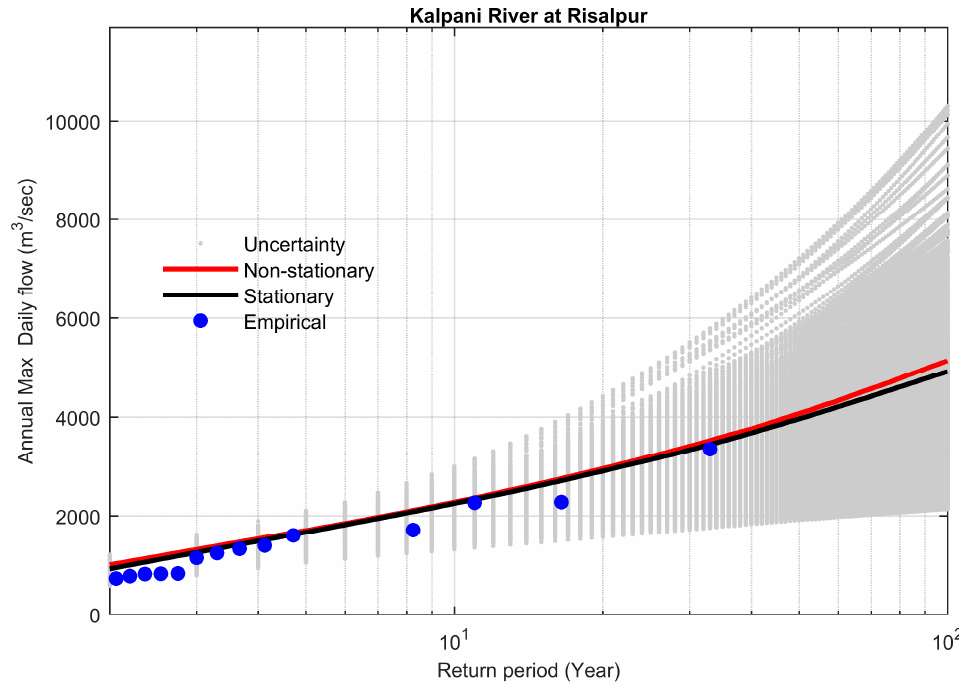
Figure 10. Comparison between non-stationary and stationary FFCs at site 19, along with non-stationary uncertainty bounds for the year 2016.